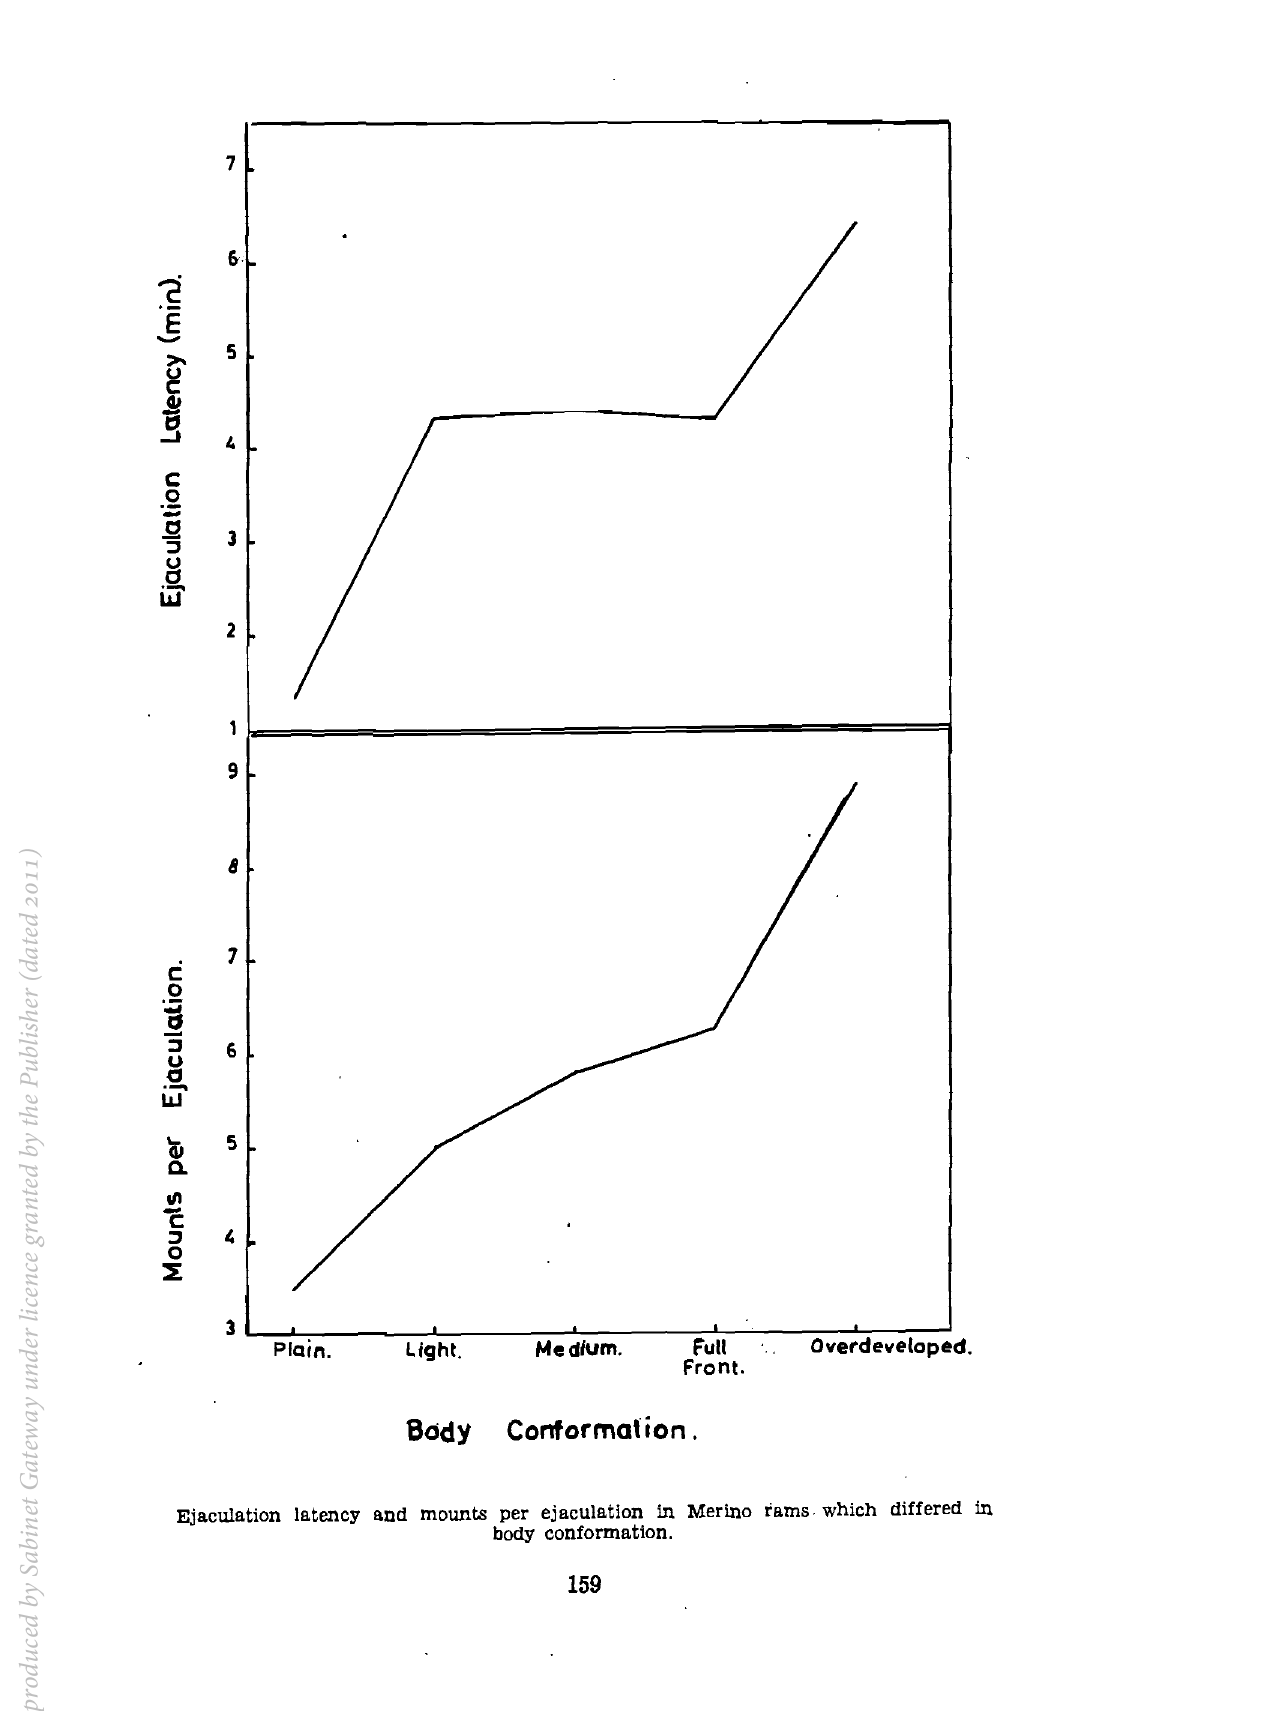
Plain. Light. Me dlum. Full BodY